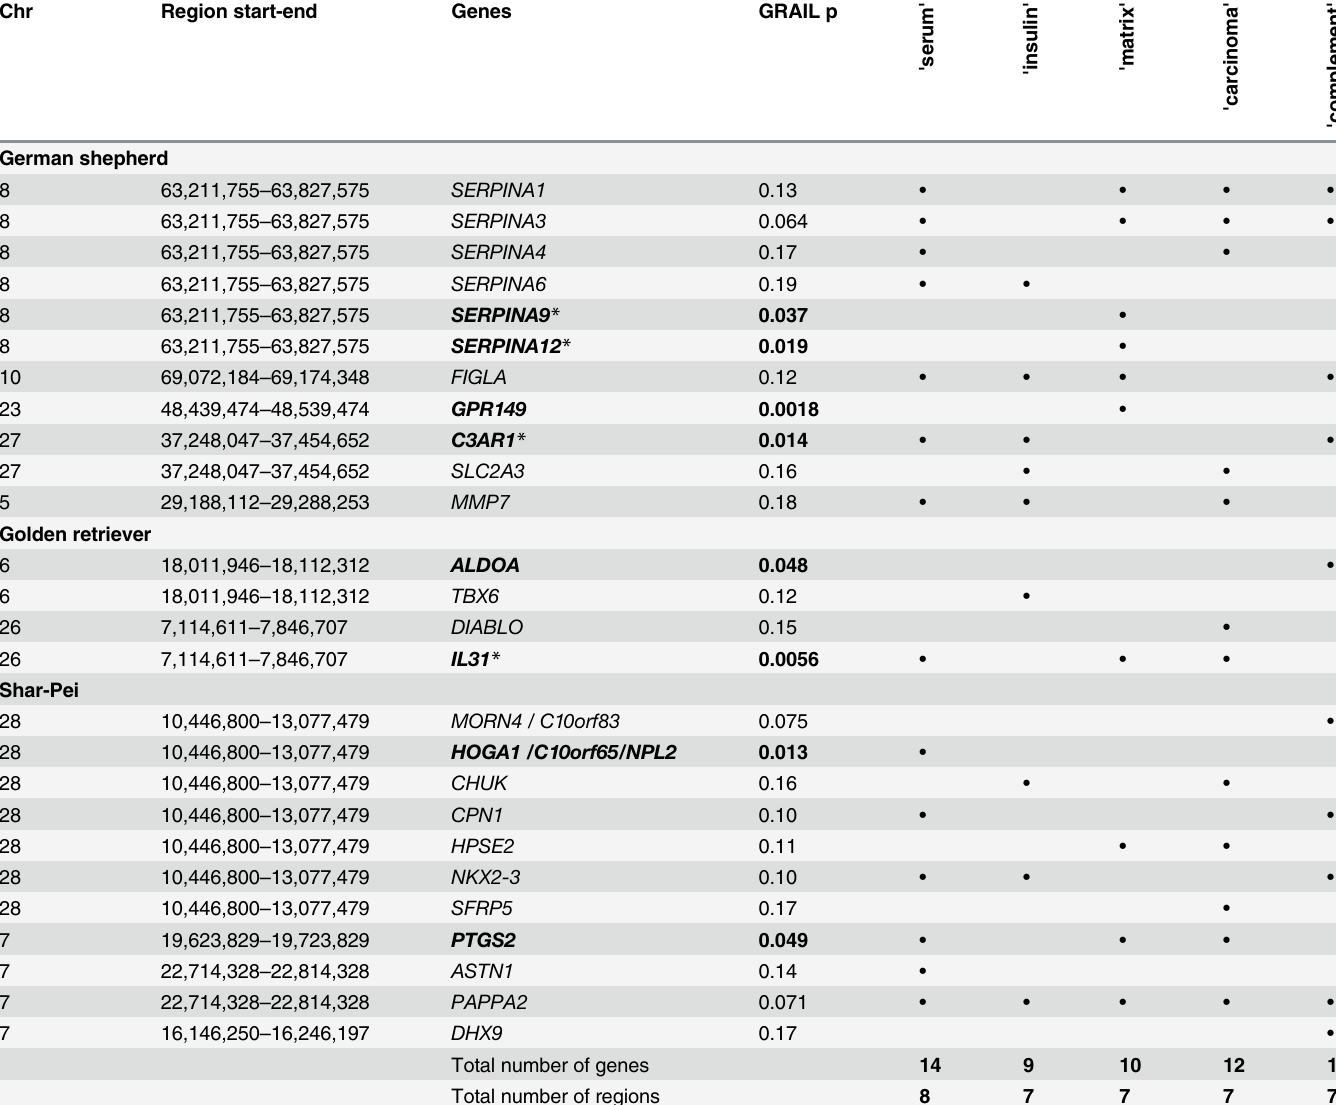
Table 2. GRAIL pathways of the IgA associated